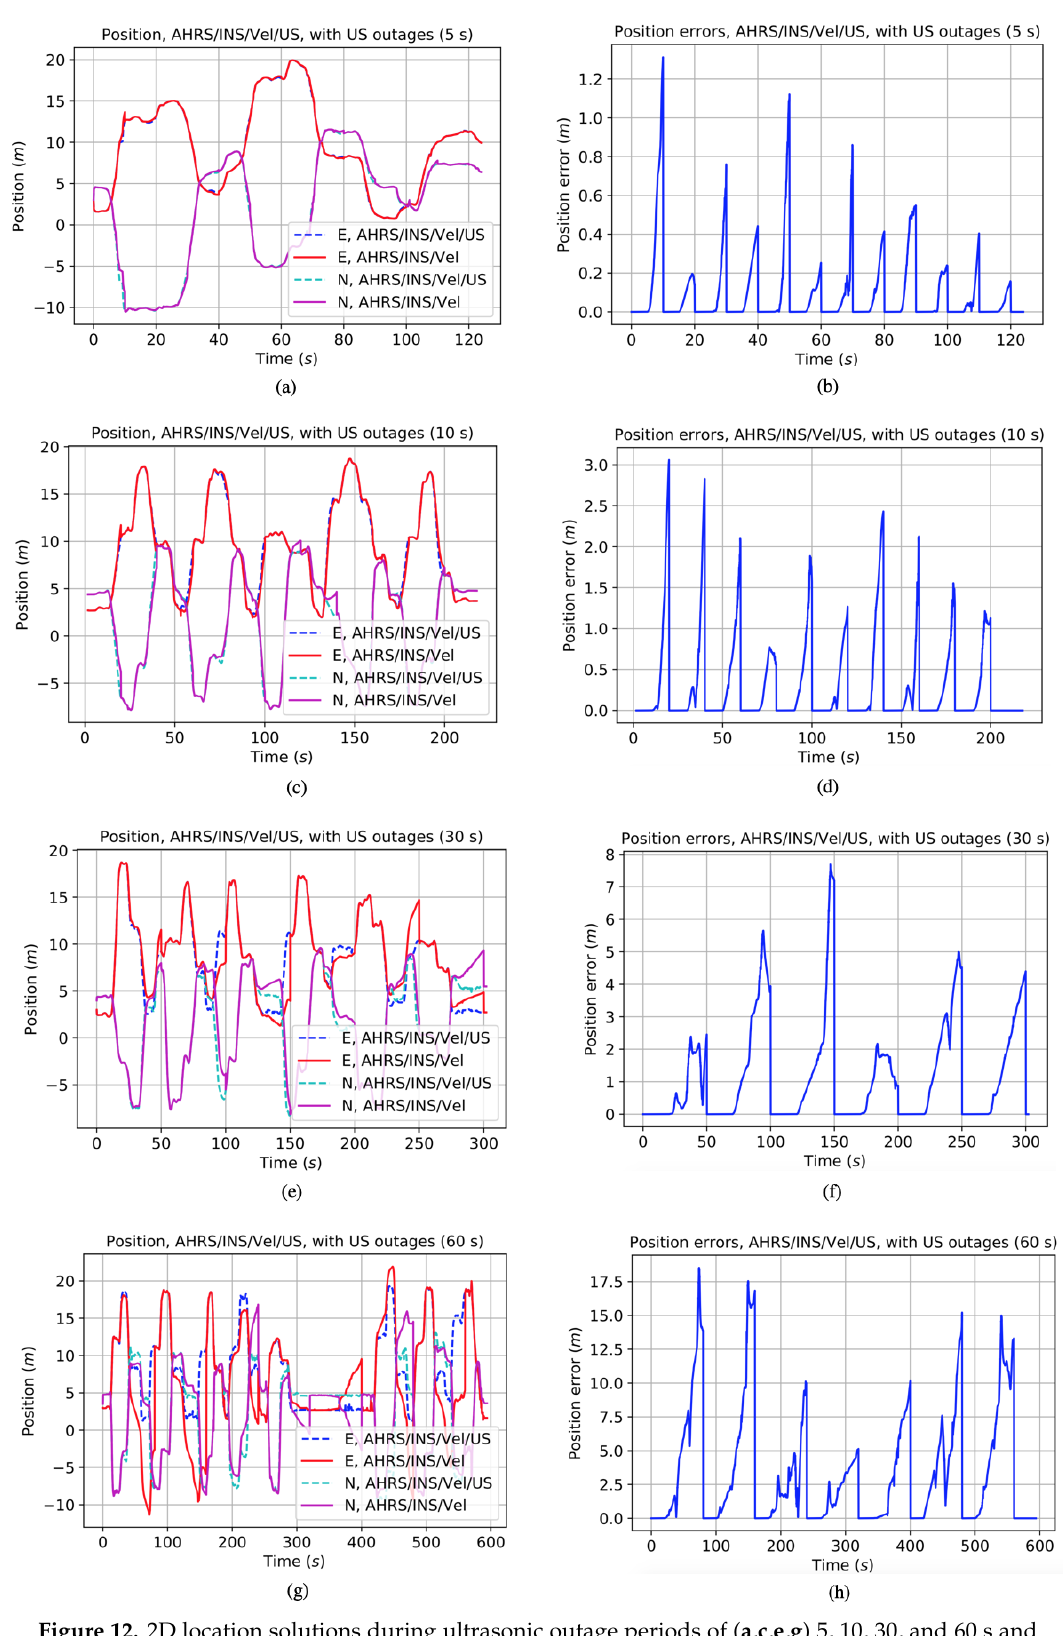
Figure 12. 2D location solutions during ultrasonic outage periods of ( a , c , e , g ) 5, 10, 30, and 60 s and ( b , d , f , h ) their location